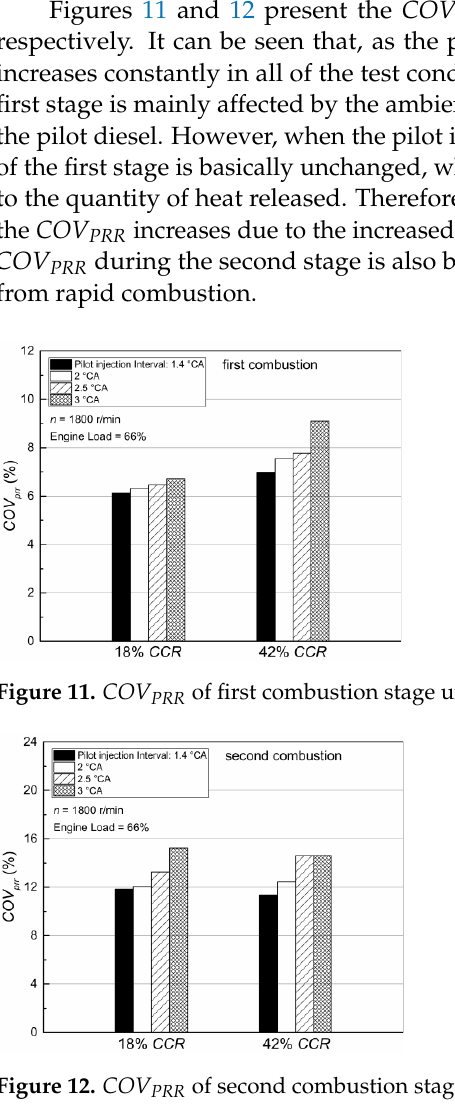
Figure 10. SOC1 and SOC2 under different pilot injection periods.